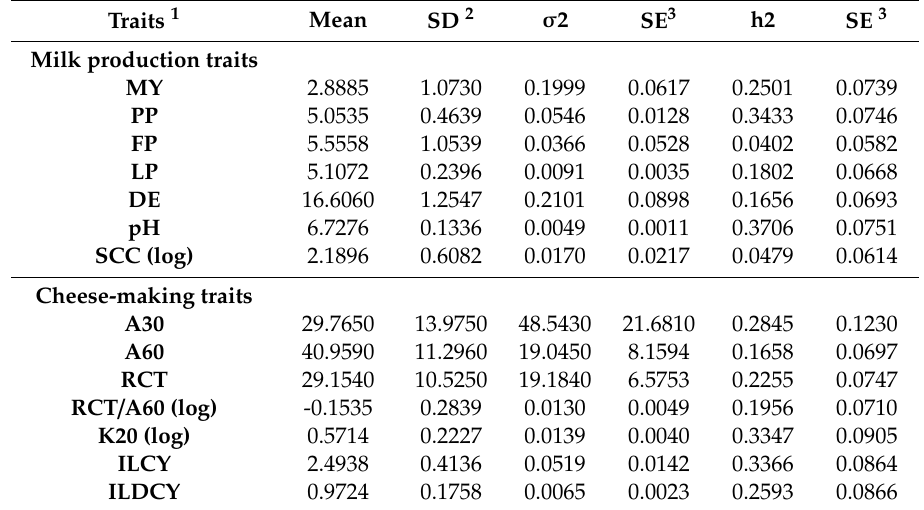
Table 3. Phenotypic means and genetic variances and heritabilities of each trait analysed in this